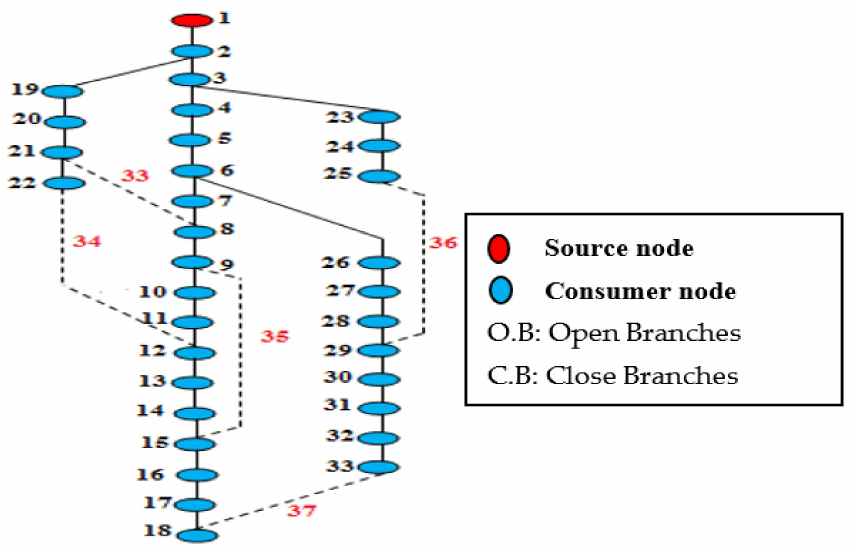
Figure 5. IEEE 33-bus test system.